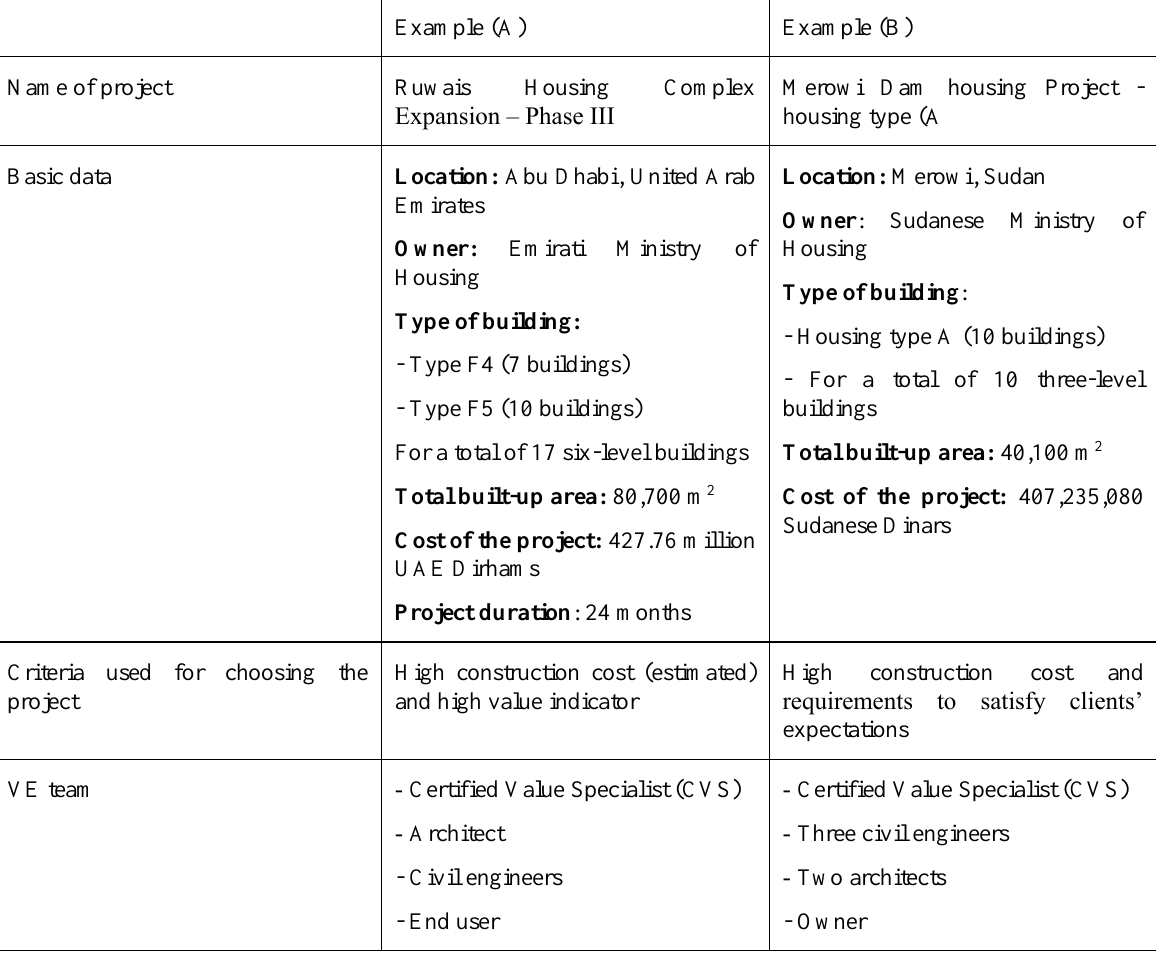
Table 1. Summary of the projects’ basic information. Source: Updated from (Jeyakumar, 2013 & Bashir,